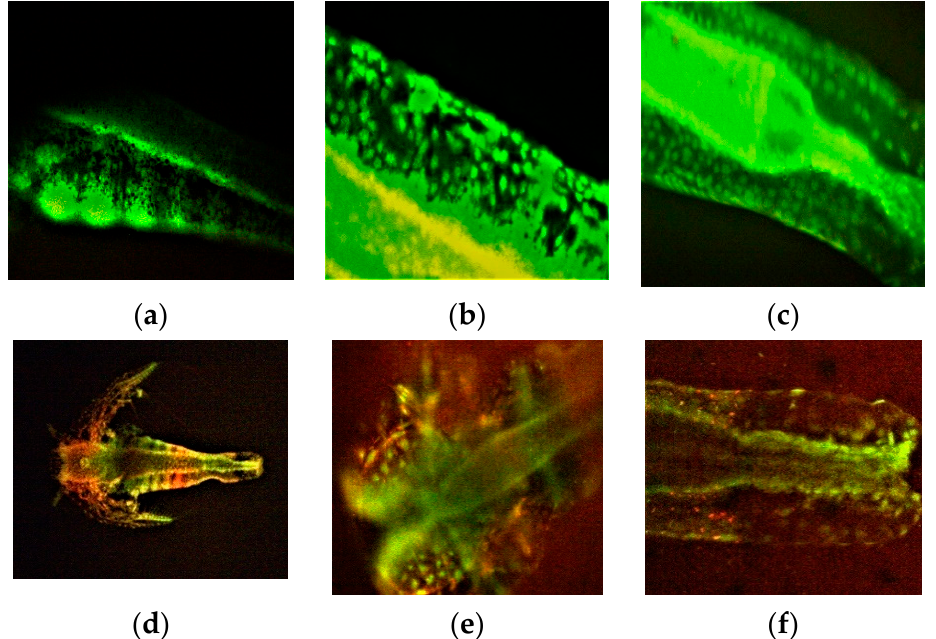
Figure 8. A. salina larvae after 48 h of exposure to F-UBE-HPC stained with acridine orange 100 × ( d ), 200 × ( b , c , e , f ), and 400 × ( a ). ( a – c )—blank; ( d – f )—samples. The red fluorescence shows intracellular lysosomes activated in cell death processes ( e , f ); F-UBE-HPC—bioadhesive oral film loaded with U. barbata dry ethanol